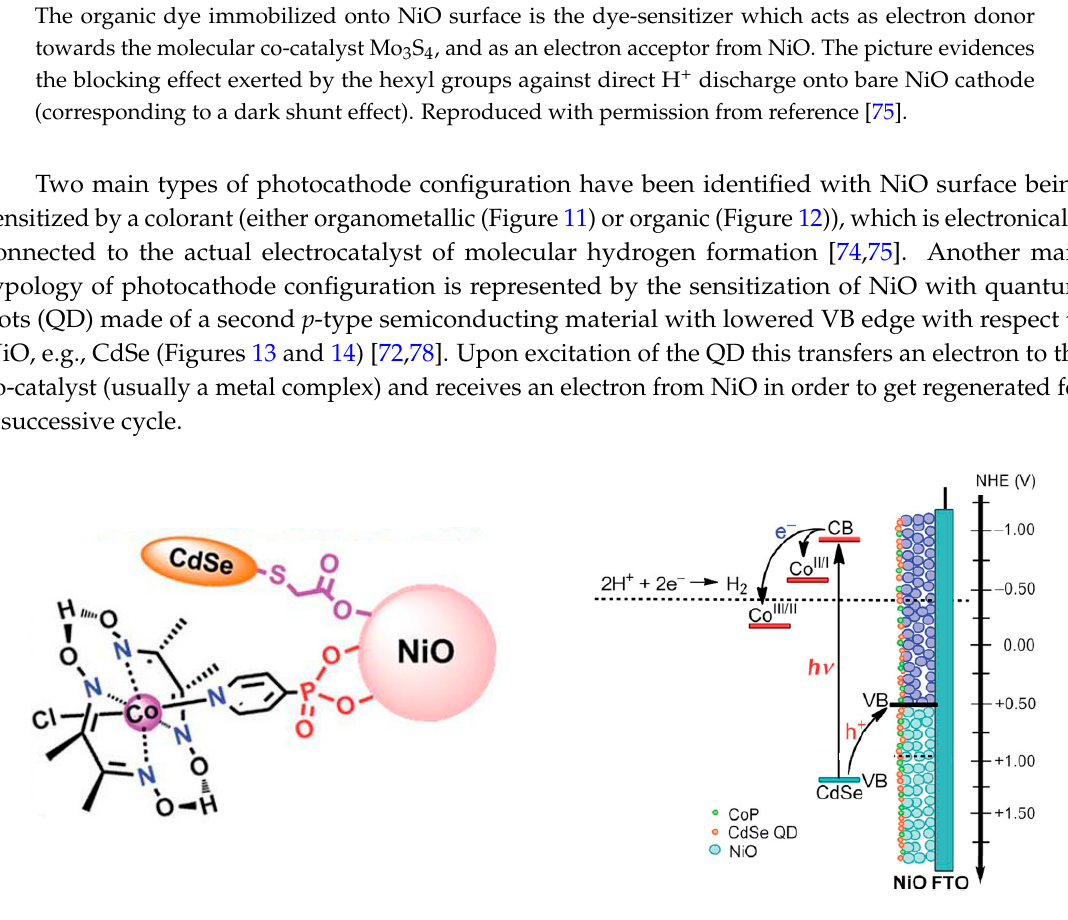
Figure 13. Left: depiction of the NiO photocathode sensitized by QD of CdSe and surface modified by the cobaloxime complex, i.e. , the catalyst of molecular hydrogen formation. Right: potential levels involved in the process of light ‐ induced ET from NiO to H + as mediated by QD sensitizer and Co catalyst. Adapted from reference [78].